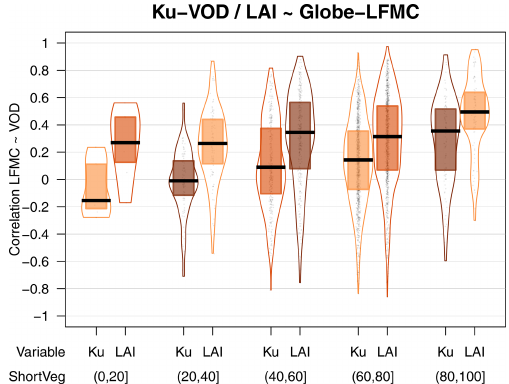
Figure A5. Statistical distributions of the temporal correlation be- tween Ku-VOD or LAI and measurements from the Globe-LFMC database stratified by the percentage cover of short